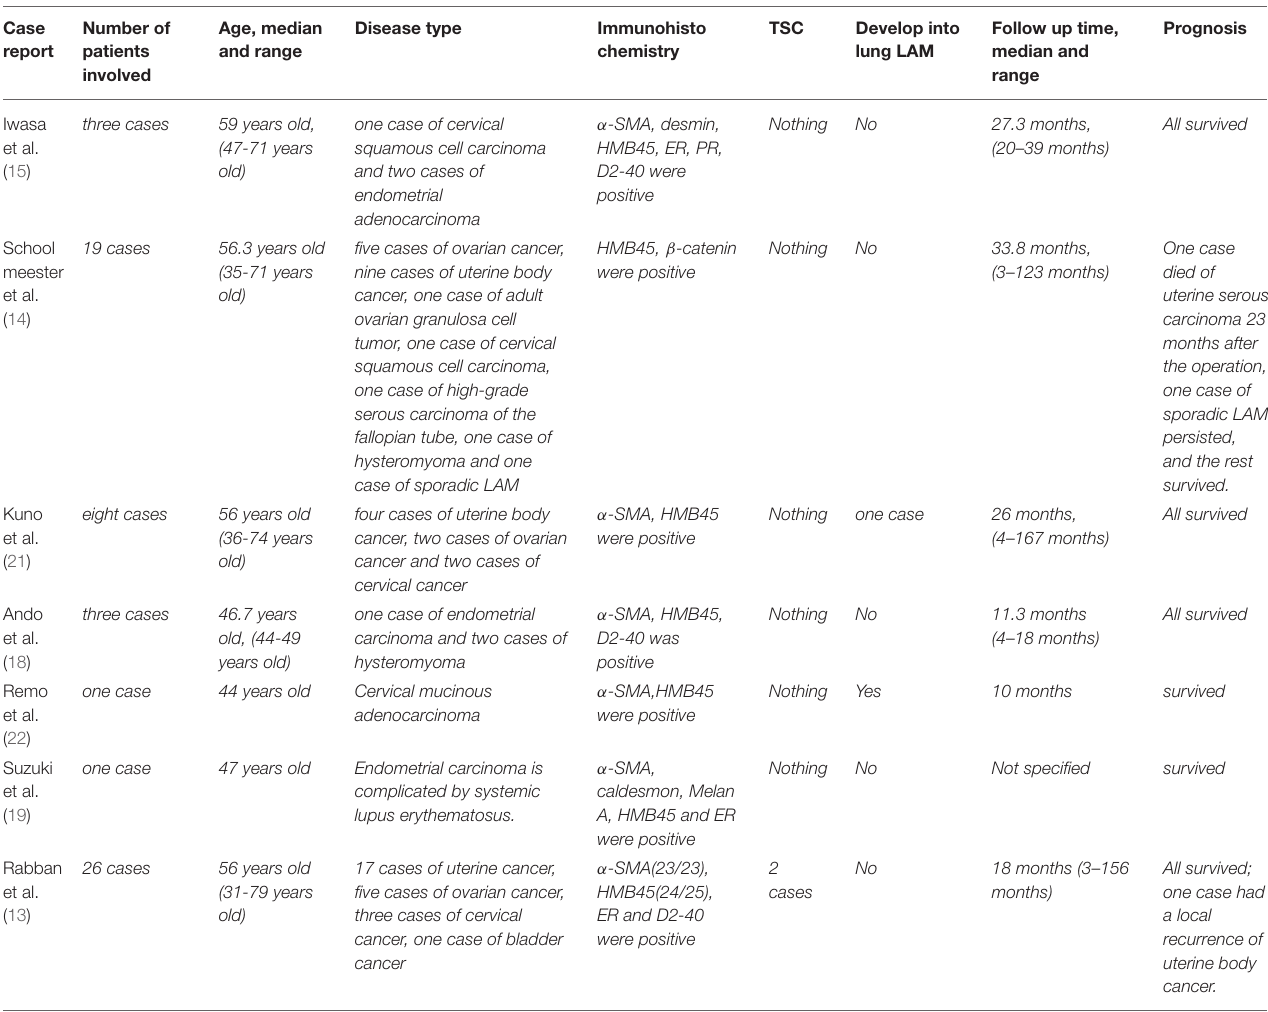
TABLE 1 | Female cases of pelvic and peritoneal lymph node LAM found during the operation. Case